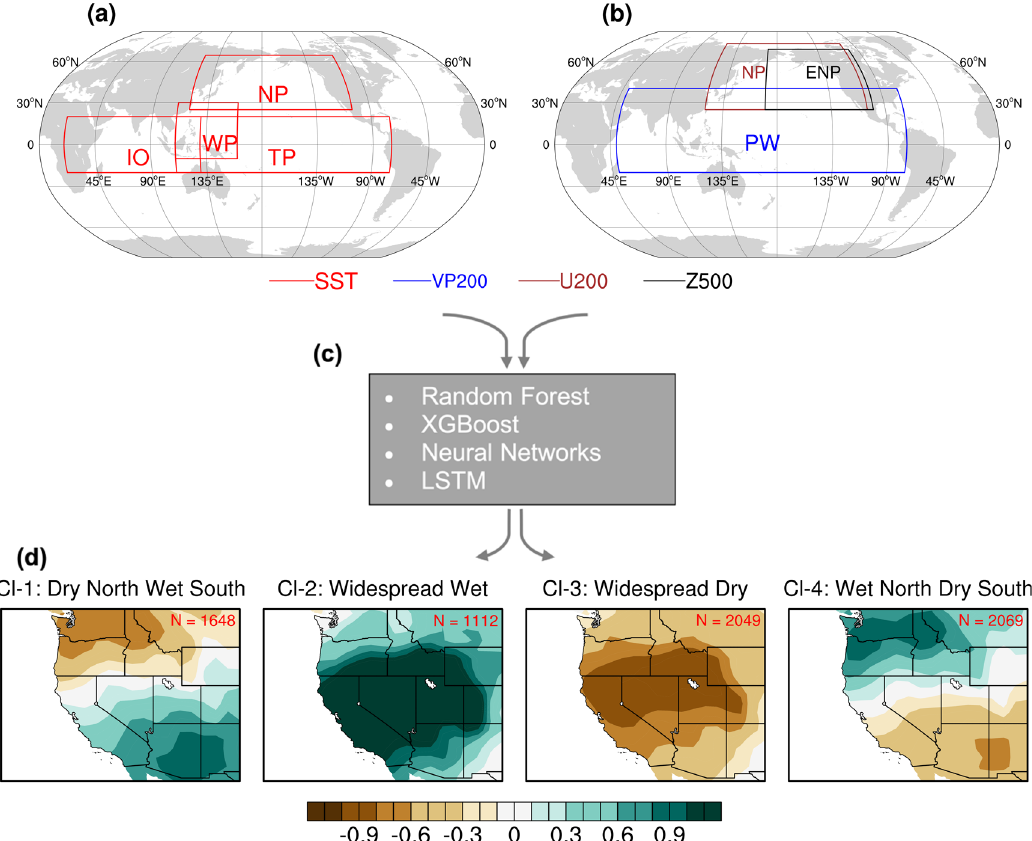
Fig. 1 Summary of methodology for seasonal cluster prediction. Panels a and b show lagged predictor variable regions from which EOFs were derived. Panel a shows ocean-based (SST) regions, panel b shows atmosphere-based (VP200, U200, and Z500) regions, with variable names referred to in the text. Panel c shows the four machine learning methods trained on CESM-LENS data/regions from panels ( a and b ). Panel d shows the predictand clusters derived from K-means clustering of 3-month standardized precipitation anomalies over the western US. The sample size (number of seasons) is shown for each cluster from CESM-LENS data. Models are trained separately for making seasonal predictions of November through January (NDJ) and January through March (JFM) clusters, using previous months as